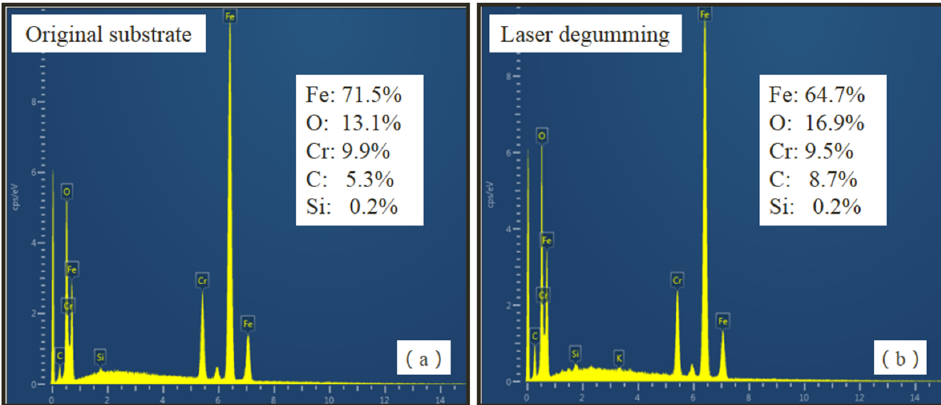
Figure 6. Energy spectrum of samples ( a ) before and ( b ) after laser degumming.